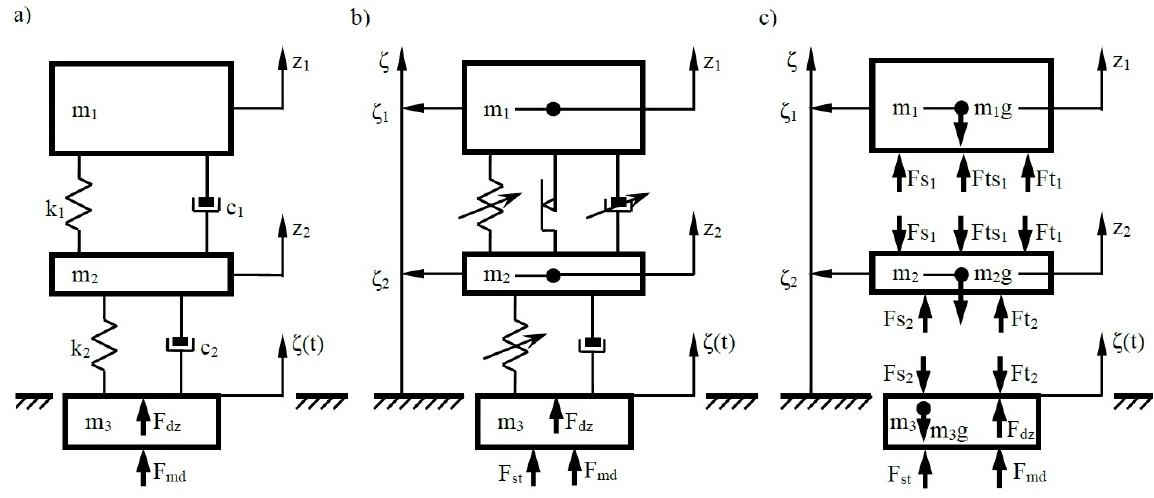
Figure 2: Quarter-car model on a diagnostic shock absorber tester: a) general structure of linear version; b) general structure of nonlinear version; c) force system in nonlinear version